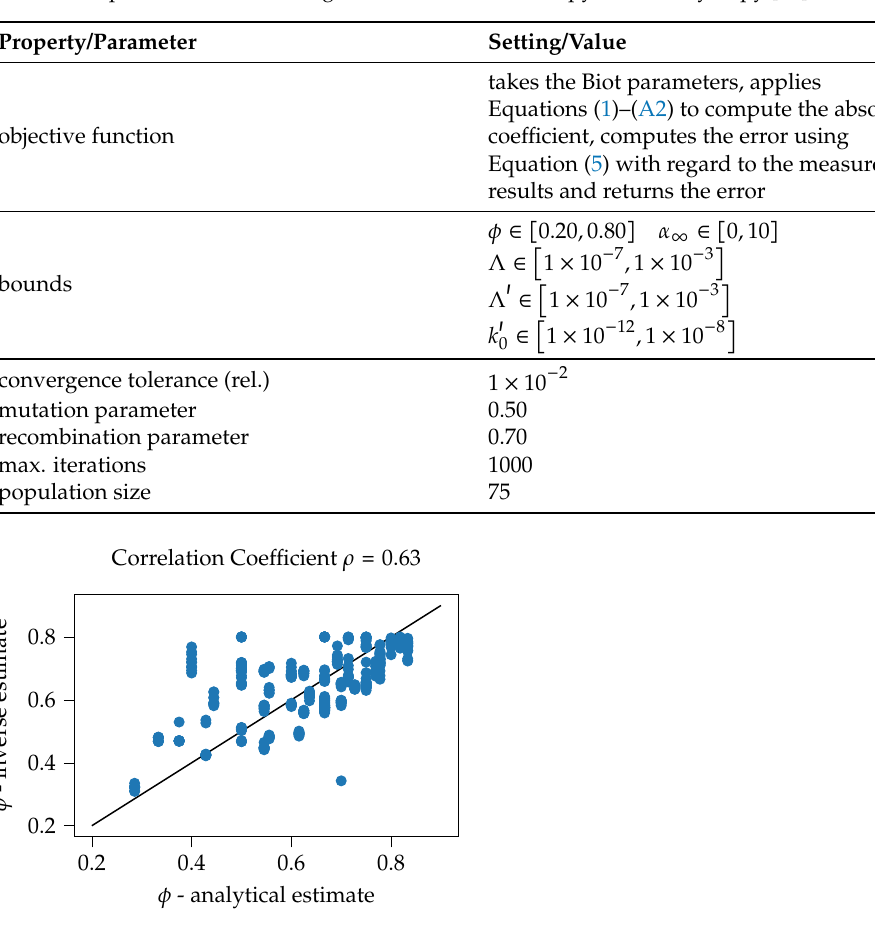
Figure C.1. A correlation plot for the inversely estimated porosity of the specimen (vertical axis) and an analytical porosity estimate, computed using s /( s + d ) . A general correlation (correlation coefficient ρ = 0.63) can be found. Therefore, it is assumed that the general procedure can be trusted.